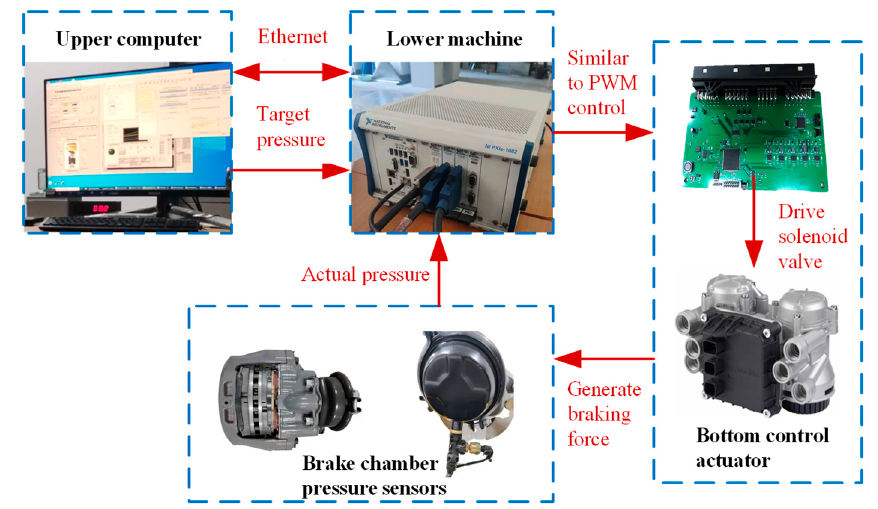
Figure 12. Logic block diagram of air pressure control HIL of the EBS bottom controller.